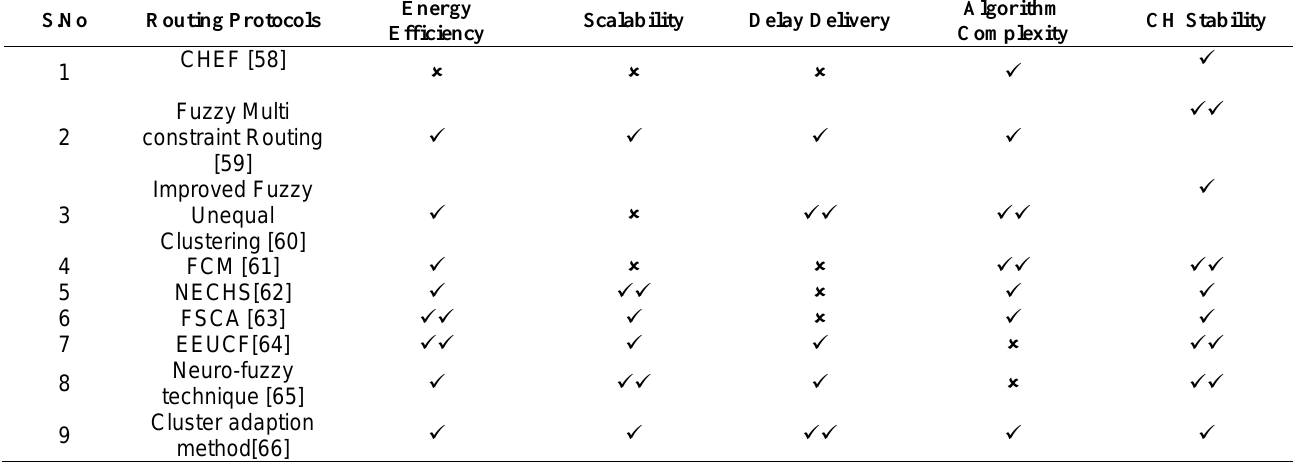
Table 6. Classification of fuzzy logic based routing